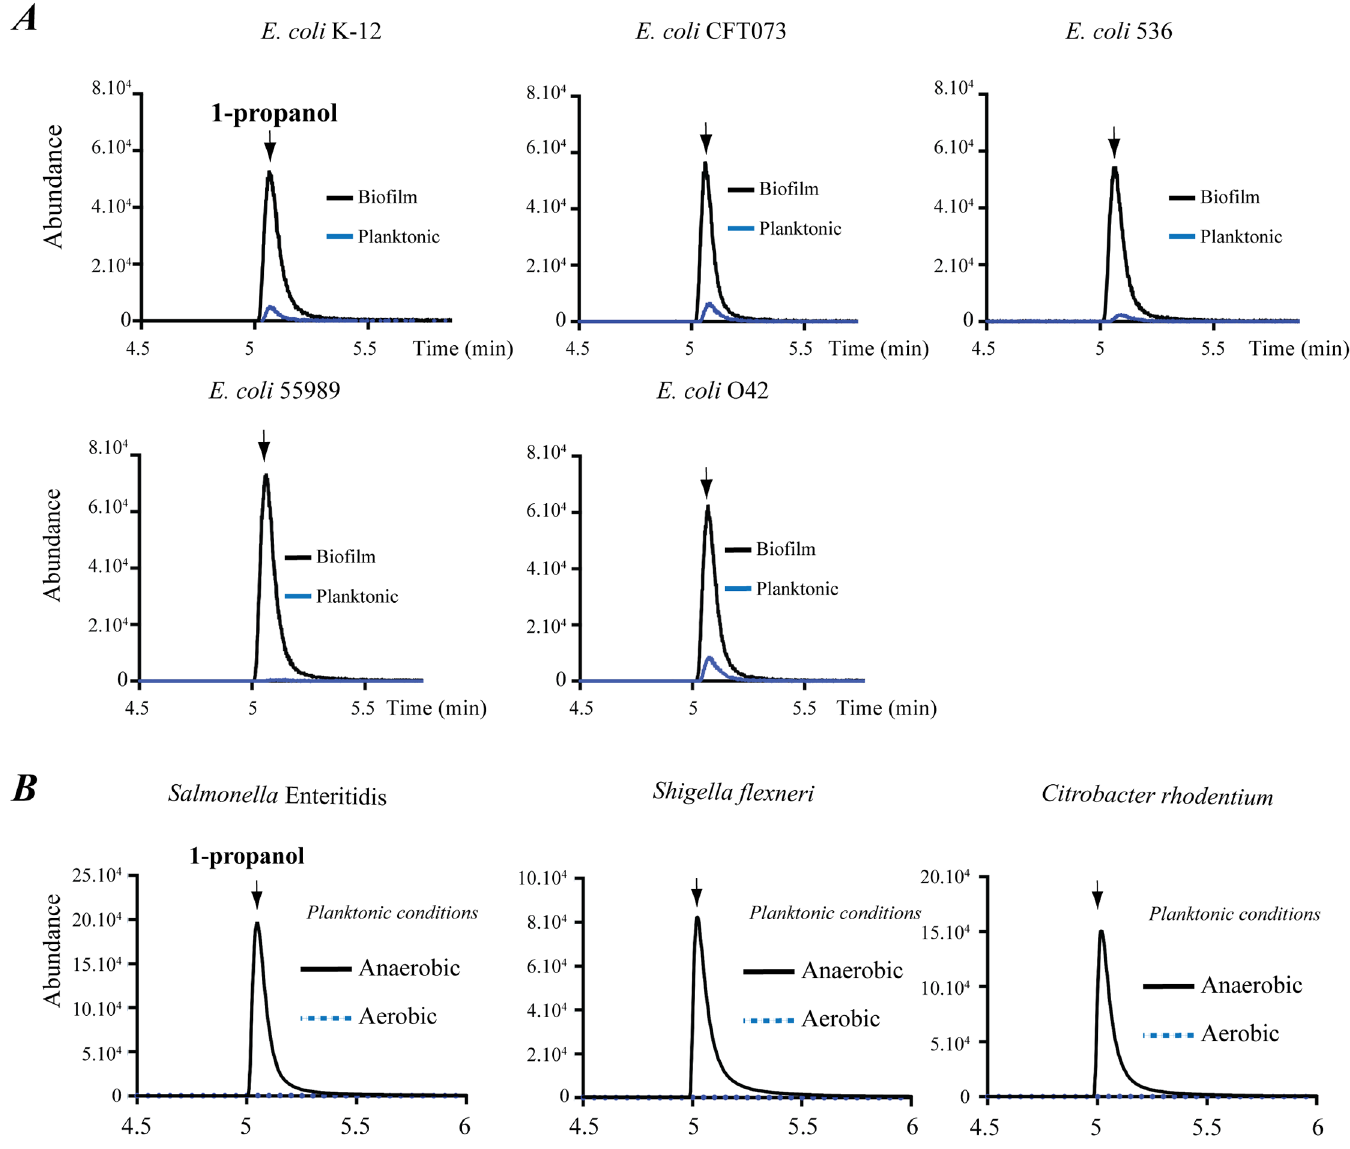
Fig 5. 1-Propanol production in E . coli and other Enterobacteriaceae . (A ) Detection of specific productionof 1-propanol in biofilms formed by commensal E . coli K-12 and pathogenic E . coli isolates. Comparison of HS-SPME/GC-MS analysisof 1-propanol emitted by E . coli biofilm or planktonic bacterial biomass grown in LB medium. Biofilm was grown for 24 h in biofilm microfermenters or in an agitatedflask in aerobicplanktonicconditions. (B) Detection of specific production of 1-propanol in the indicated Enterobacteriaceae .Comparison of HS-SPME/GC-MS analysisof 1-propanol emitted by planktonic bacterial biomass grown in LB medium in anaerobicor aerobic conditions. No HS-SPME/GC-MS 1-propanol signal was detected in anaerobicor aerobiccultures of the followingbacteria: Enterobacter cloacae , Proteus mirabilis , Klebsiella pneumoniae , Aeromonashydrophila . Abundance:arbitrary unit proportional to the number of detected m/z